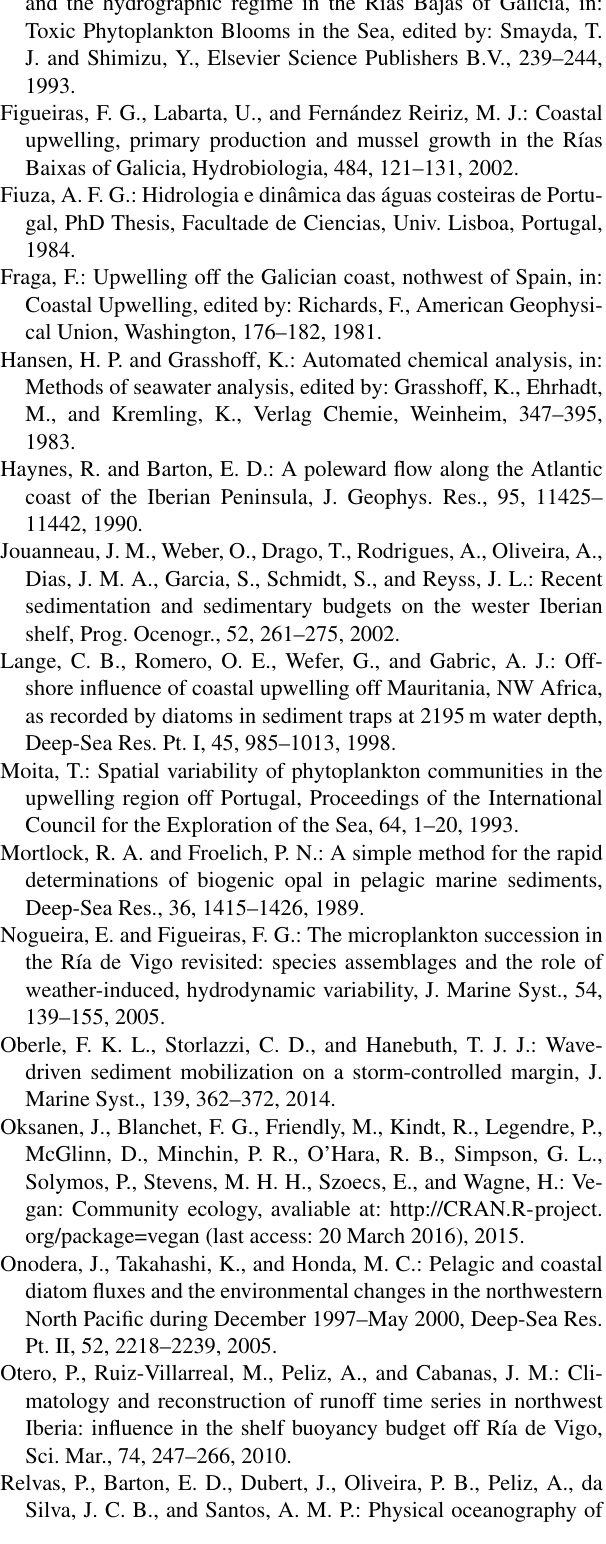
Figueiras, F. G. and Rios, A. F.: Phytoplankton succession, red